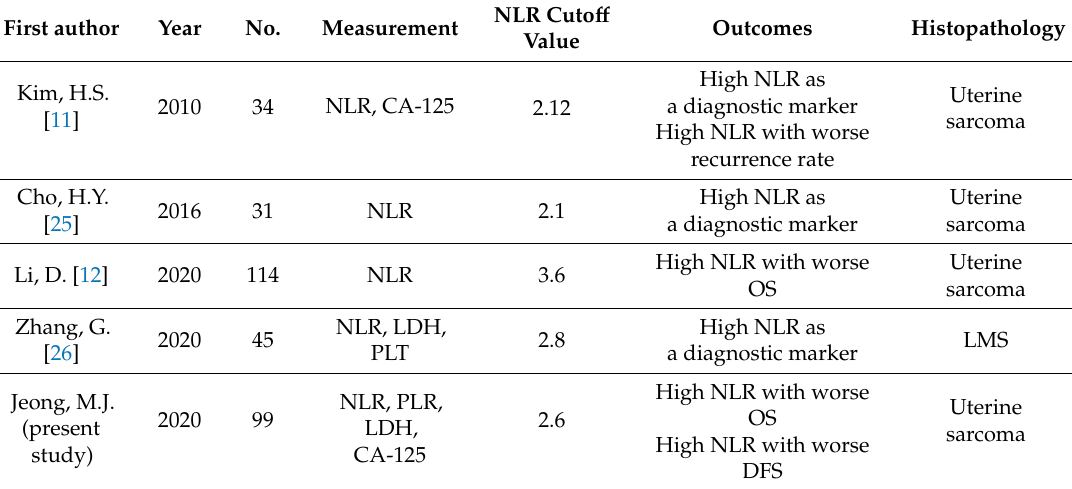
Table 5. Overview of uterine sarcoma studies using